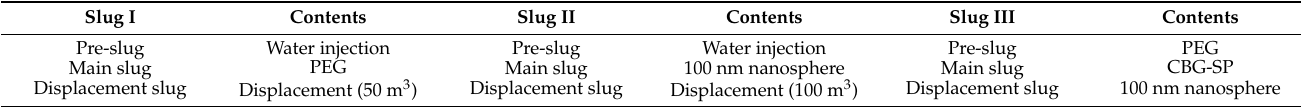
Table 13. Three practical slug configurations of PCAs.